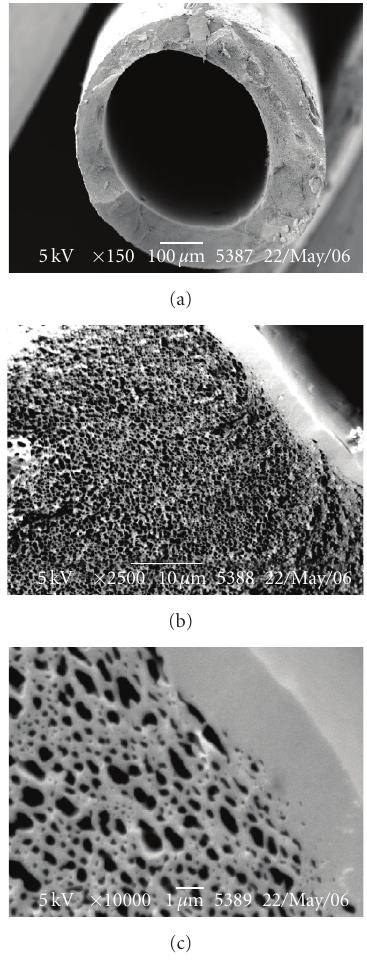
Figure 5: SEM pictures from HF-700-B carbon hollow fiber membrane cross-sections: (a) global view, × 150 magnification, (b) inner view, × 2500 magnification, and (c) inner view, × 10000